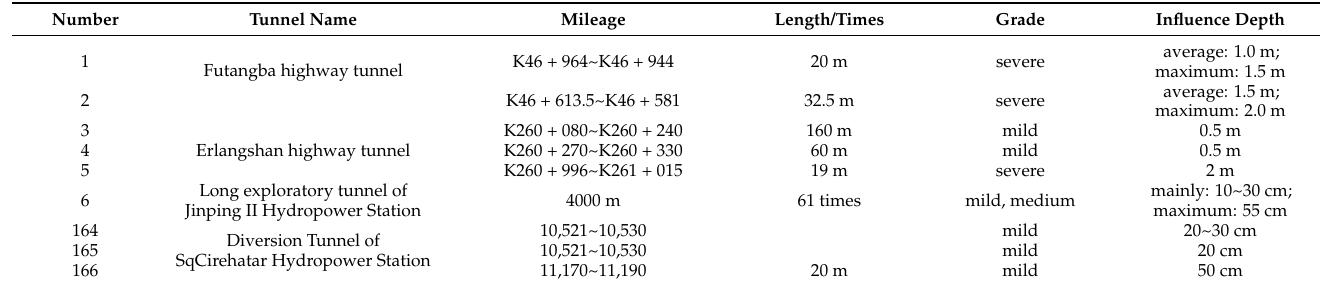
Table 3. Statistical table of influence depth of rockburst of different grades.